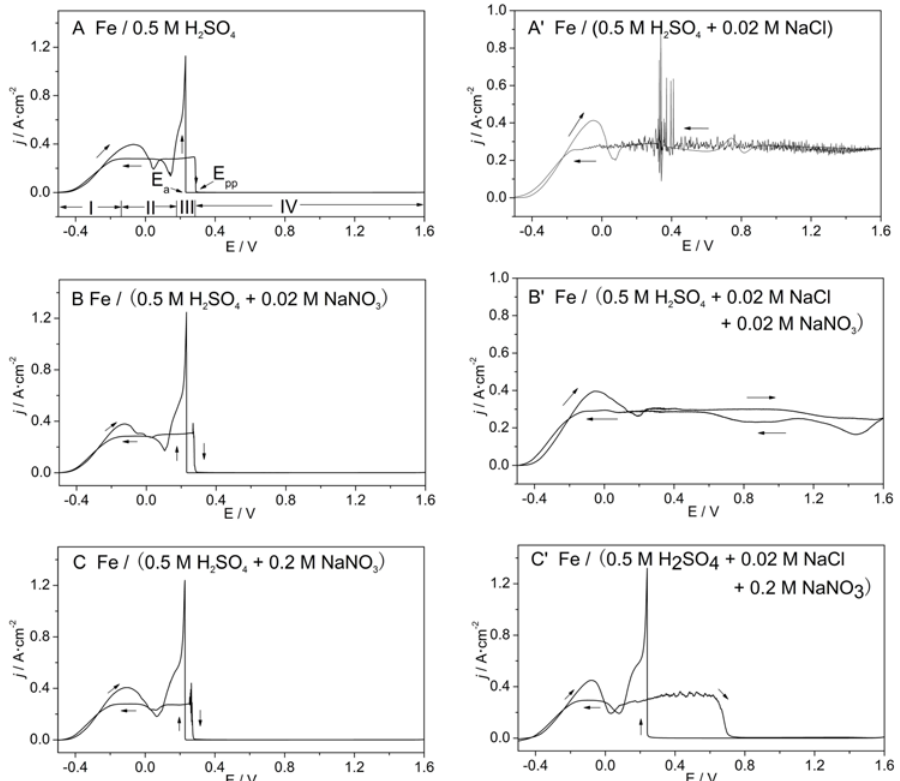
Figure 2. The cyclic voltammetry curves of the iron electrodes at d E / d t = 10 mV / s in various solutions ( A ) 0.5 M H 2 SO 4 ; ( A’ ) 0.5 M H 2 SO 4 + 0.02 M NaCl; ( B ) 0.5 M H 2 SO 4 + 0.02 M NaNO 3 ; ( B’ ) 0.5 M H 2 SO 4 + 0.02 M NaCl + 0.02 M NaNO 3 ; ( C ) 0.5 M H 2 SO 4 + 0.2 M NaNO 3 ; ( C’ ) 0.5 M H 2 SO 4 + 0.02 M NaCl + 0.2 M NaNO 3 . Table1. E ff ectsofNO 3 − ionsand / orCl − ionsontheprimarypassivepotential(E pp )indi ff erentsolutions.